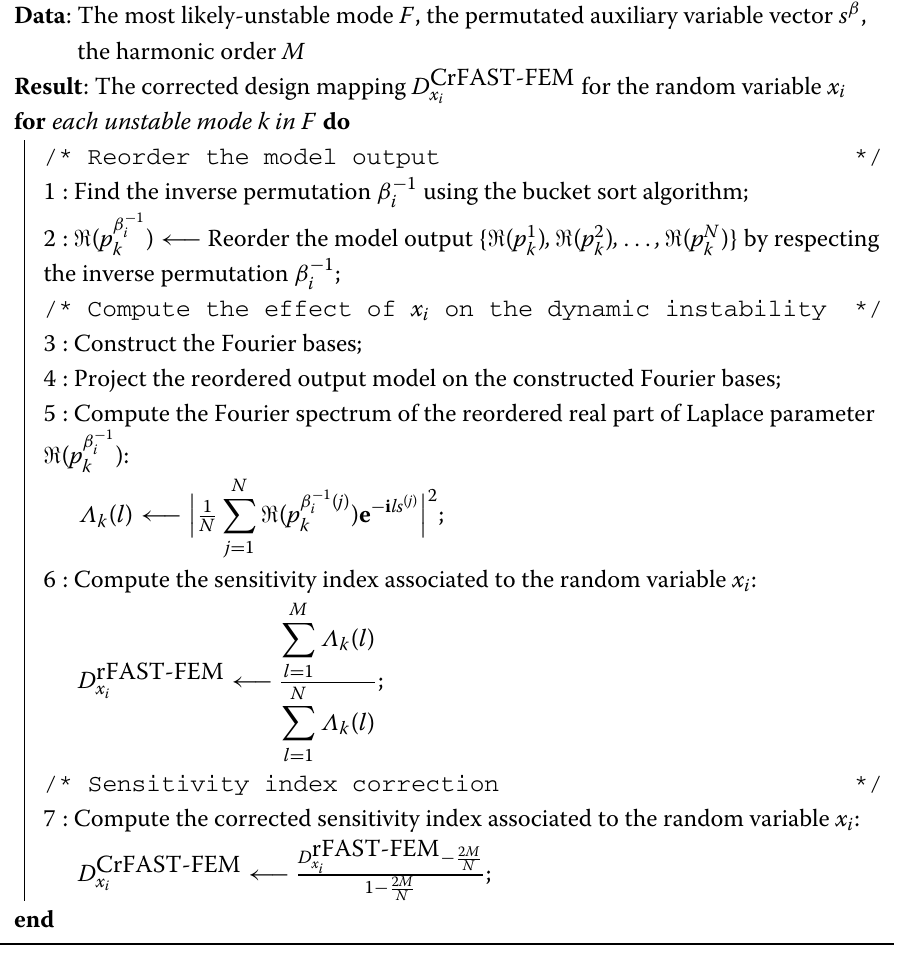
Algorithm 2: Post-processing module - Design mapping